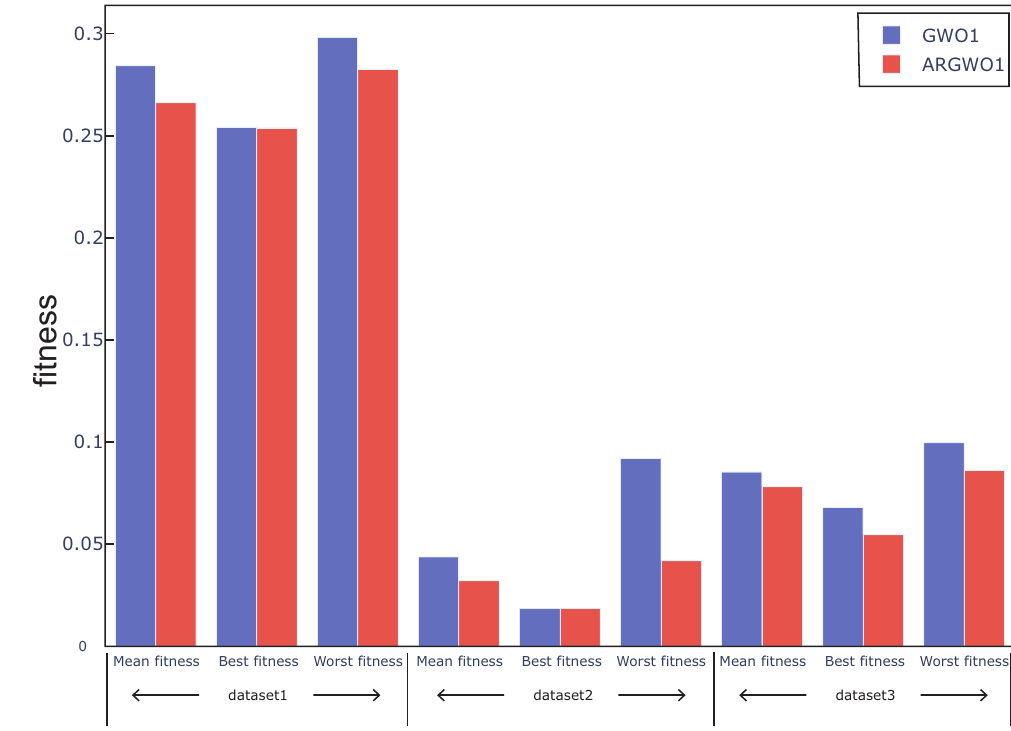
Figure 6. Mean, best, and worst fitness obtained from GWO1 and ARGWO1 over all